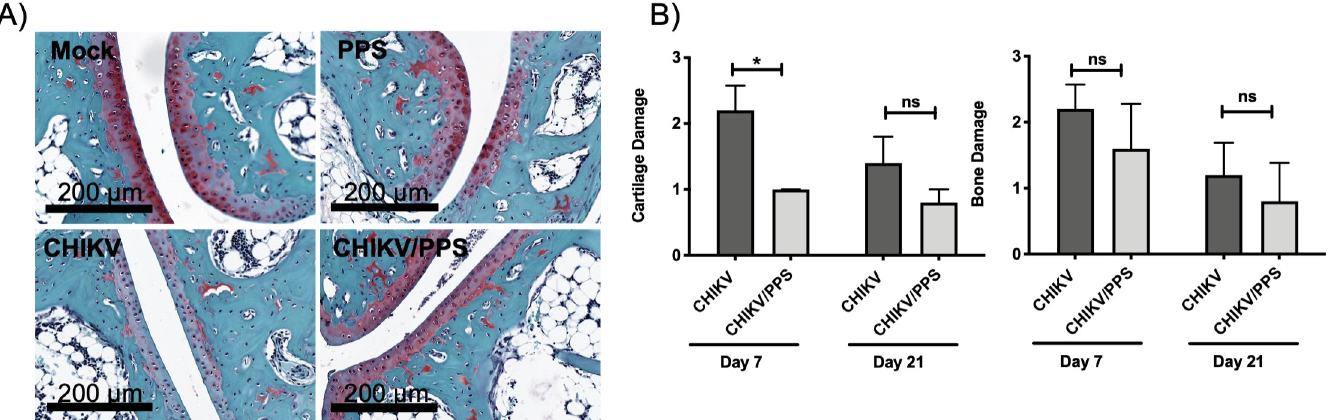
Fig 3. Safranin O staining of articular cartilage in the calcaneal joint. C57BL/6 mice were infected s.c. with 10 4 PFU CHIKV or PBS alone and received daily injections of PPS-treatment or mock-treatment with PBS. Mice were sacrificed at 7 d.p.i. and ankle joint including foot collected, decalcified and fixed for safranin O staining. (A) CHIKV-infected PPS-treated mice showed less depletion of sulfated glycosaminoglycans compared to CHIKV-infected untreated mice. High magnification images were taken at peak disease (7 d.p.i.). Slides were scanned with the Aperio Scan Scope XT digital slide scanner. Scale bars represent 200 μ m. Images are representative of 5 mice per group. (B) The extent of cartilage and bone damage was determined by scoring for histopathological changes with sample identity blinded to the reader. To assess cartilage damage, changes in cartilage were scored 0–4 ranging from within normal limits to severe depletion of sulfated glycosaminoglycans and cartilage shrinkage [7 d.p.i. CHIKV-infected untreated 2.2 ± 0.4 vs 1.0 ± 0.002 CHIKV-infected PPS-treated ( � P = 0.0125)]. Bone damage was scored 0–4 ranging from within normal limits to severe osteoclast/osteoblast activity, bone necrosis and vascular changes. No statistical significance was seen between CHIKV-infected untreated and CHIKV-infected PPS-treated groups (n = 5 animals/group). Student t-test correction . https://doi.org/10.1371/journal.pone.0255125.g003 PLOS ONE | https://doi.org/10.1371/journal.pone.0255125 September 7,